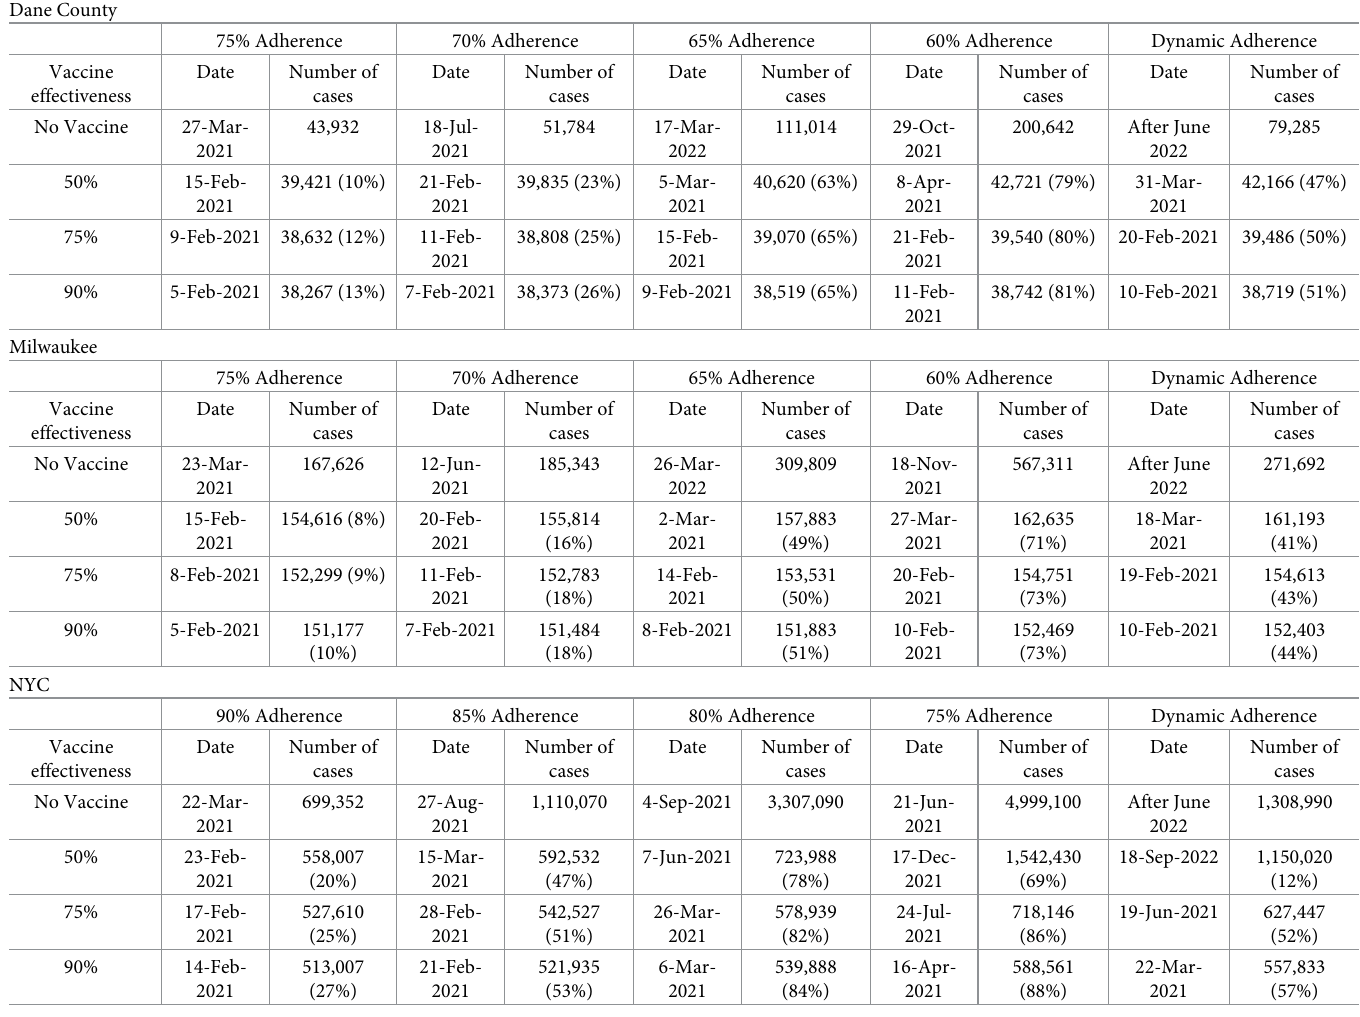
Table 3. Controllable spread date and number of cases on December 31, 2021 for different vaccination effectiveness scenarios (vaccine coverage 50%, vaccination capacity 0.25%). Dane